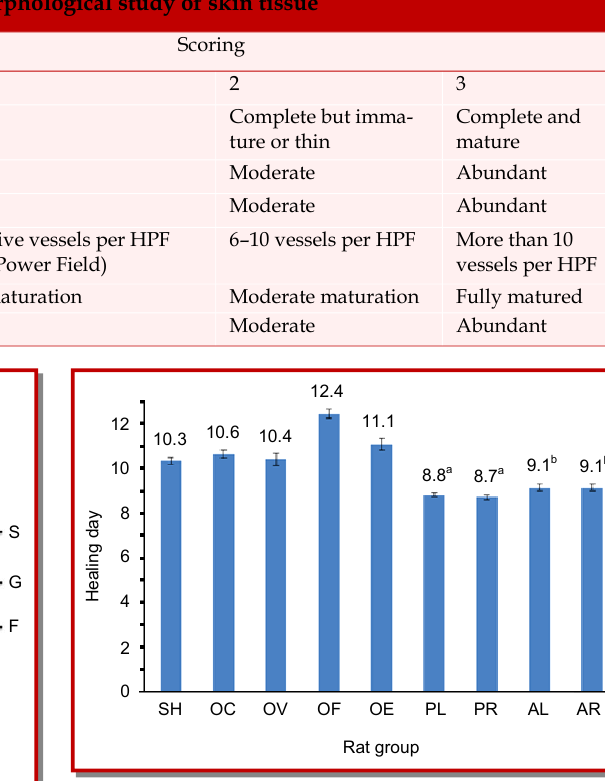
Figure 2: Bar chart represents the mean value of wounds healed day of nine ovariectomized female experimental groups: SH, OC, OV, OF, OE, PL, PR, AL and AR. Statistically significant results indicated as a p < 0.001 versus control groups (SH, OC, OV, OF and OE) and b p<0.05 versus control groups (SH, OC, OV, OF and